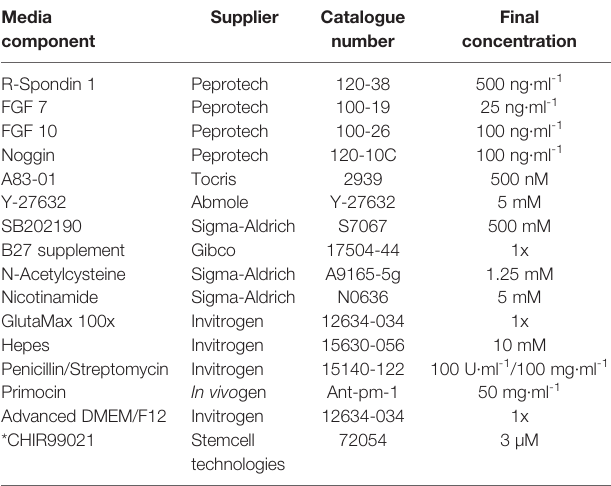
TABLE 1 | Airway and lung organoid medium, adapted from Sachs et al., and Hoareau et al., (Sachs et al., 2019; Hoareau et al., 2021). Media